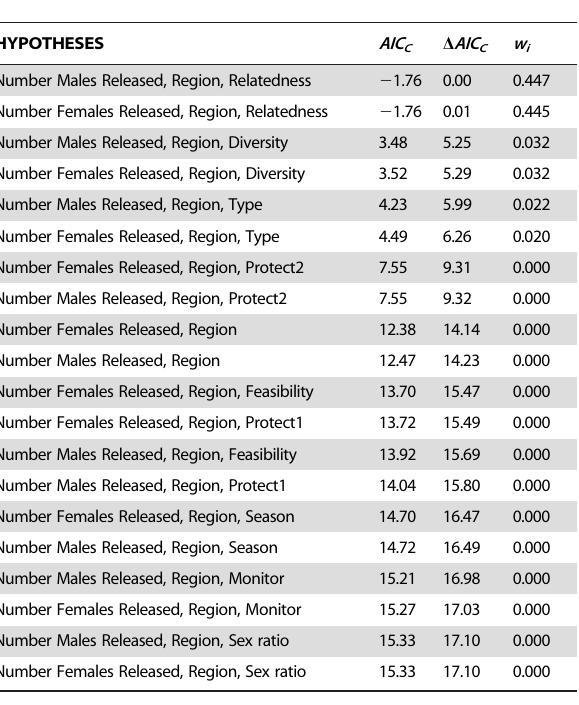
Table 7. Alternative hypotheses that may affect reintroduction success, and their ranking using AIC C